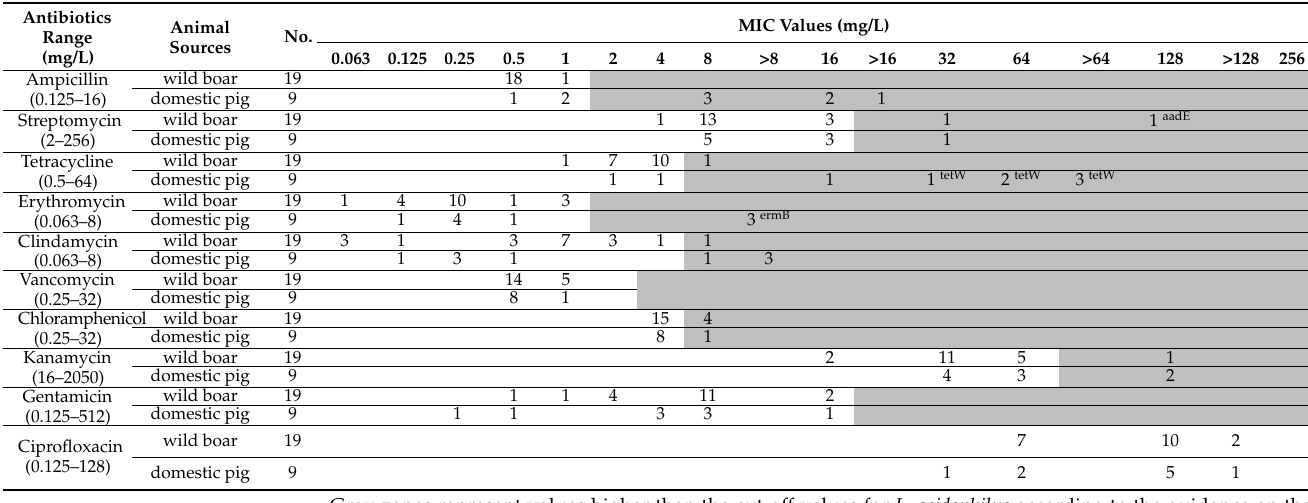
Table 3. Distribution of minimal inhibition concentration (MIC) in L. amylovorus derived from wild boars and domestic